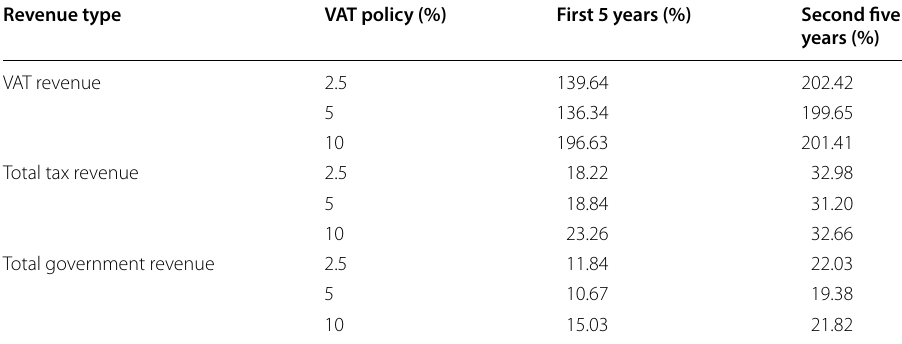
Table 1 Percentage changes in government revenue over the base run across periods Source : Model simulations Revenue